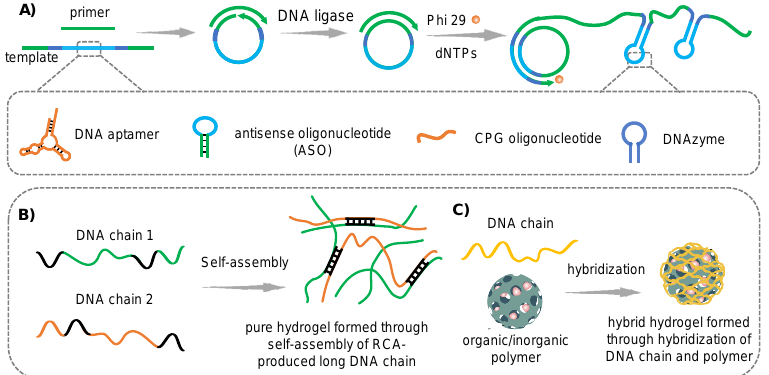
Figure 6. ( A ) The schematic of RCA principle. ( B ) Pure hydrogel formed through self-assembly of RCA-produced long DNA chain. ( C ) Hybrid hydrogel formed through hybridization of DNA chain and organic/inorganic polymer.